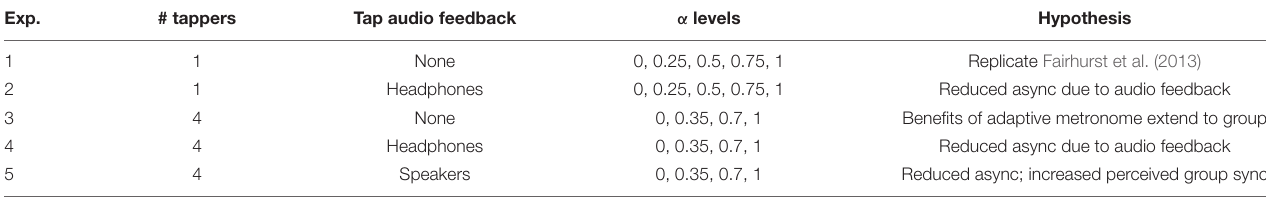
TABLE 1 | Summary of experiments, conditions, and hypotheses.